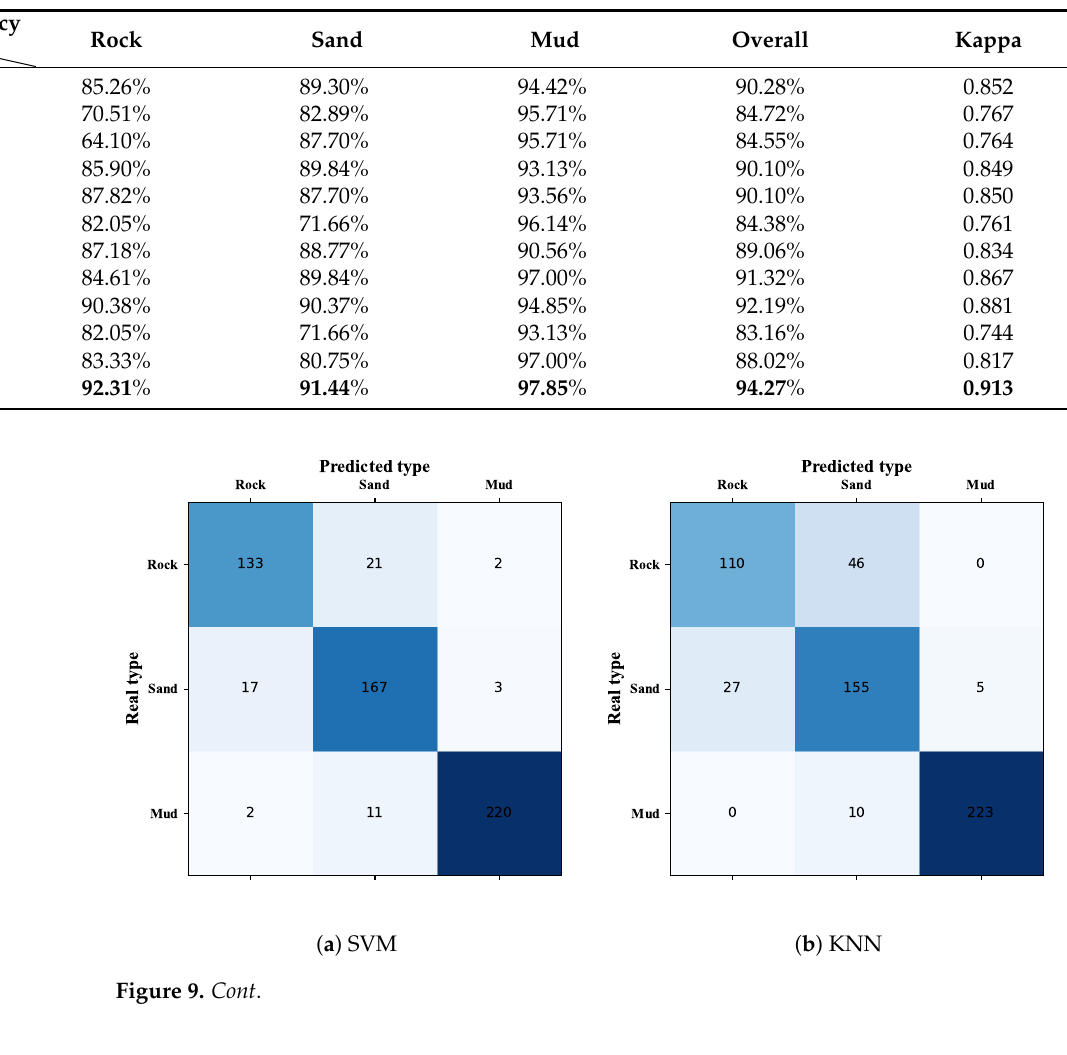
Table 8. Classification accuracy and kappa coefficient of different classifiers trained using the original training set.